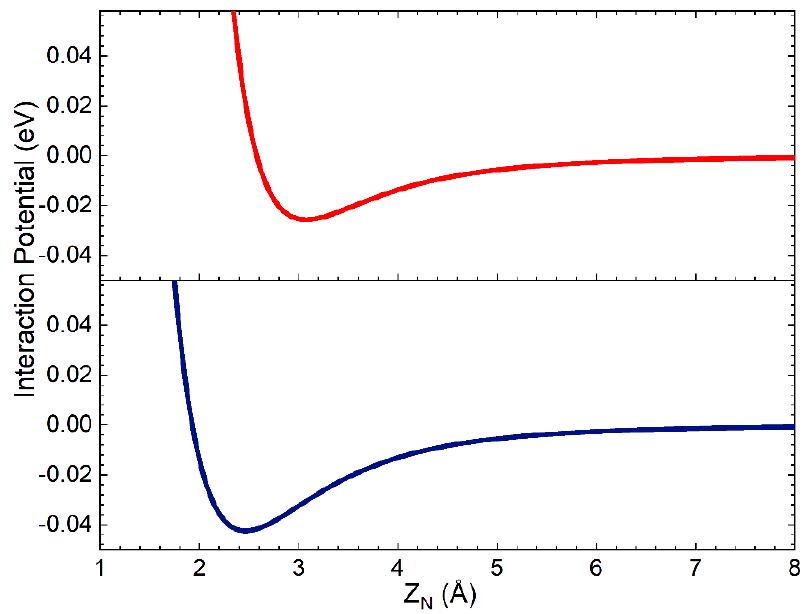
Figure 2. Interaction potential for the nitrogen atom interacting on the O atom in the first sublayer (red line) and on a Si atom in the second sublayer (blue line), in the assumed model crystal lattice, that involves, in the V N-silica formulation, effective Z N values larger than 4.0 Å.